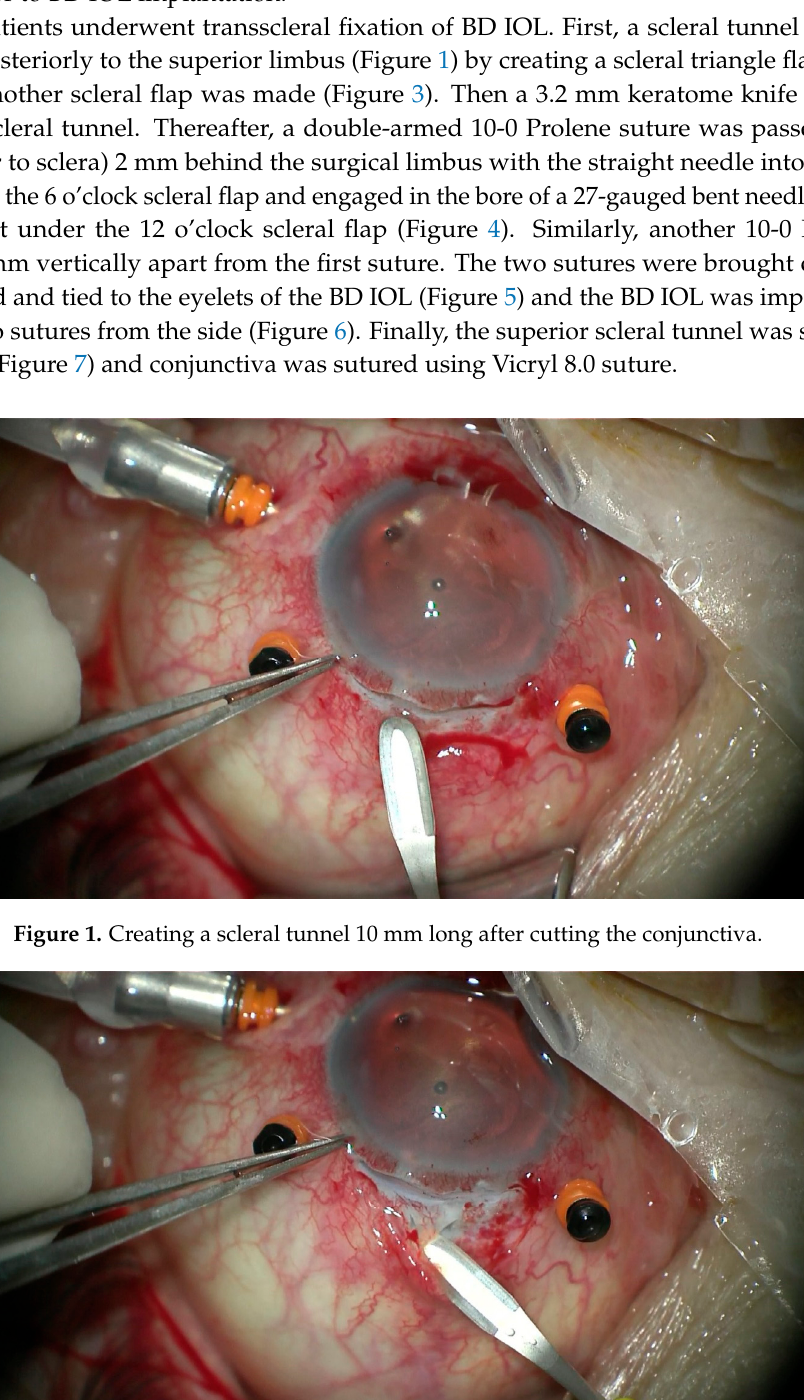
Figure 3. Performing the second scleral flap at 6 o’clock.